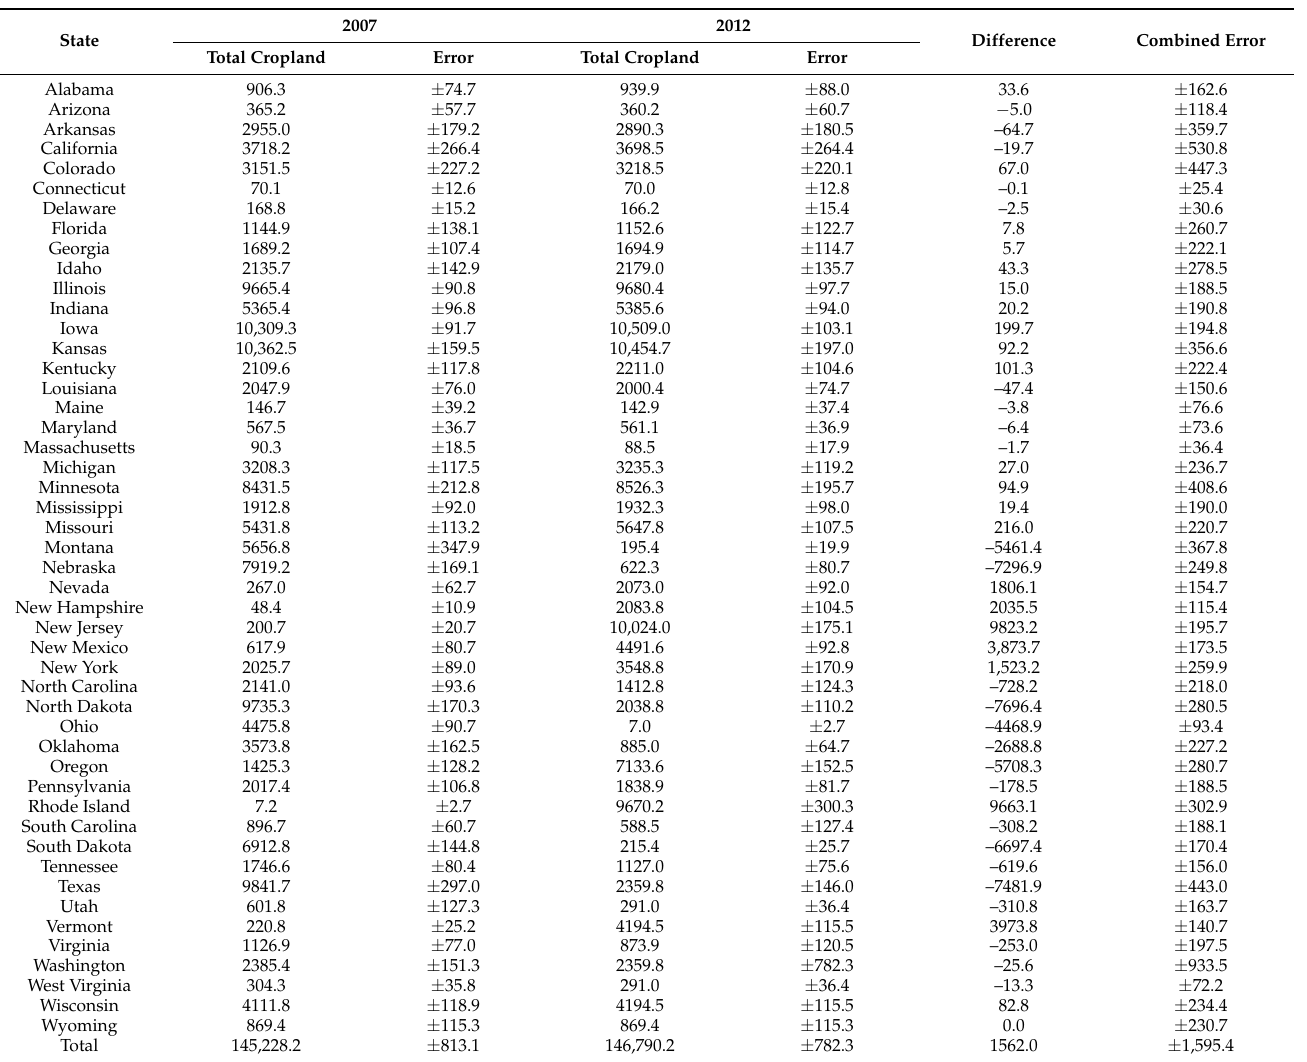
Table A2. State and national level total cropland estimates of 2007 and 2012 and the difference between the two years with estimated error margins in thousands of